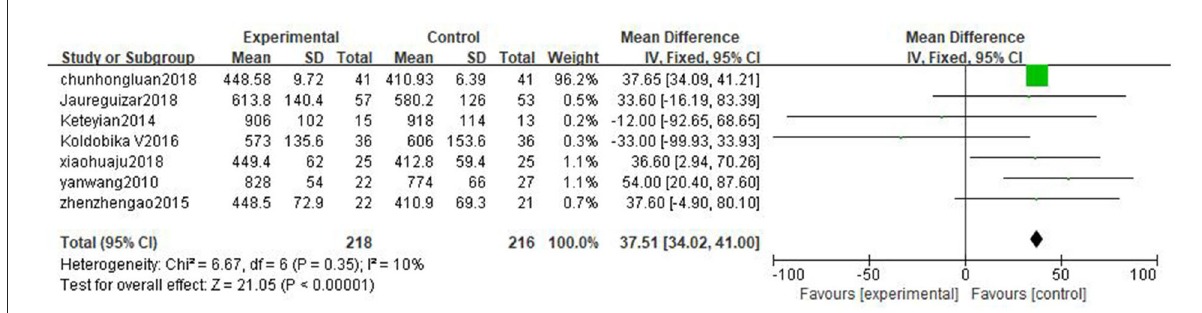
FIGURE6 Forest plot comparing the effects of two exercise modes on ED improvement.